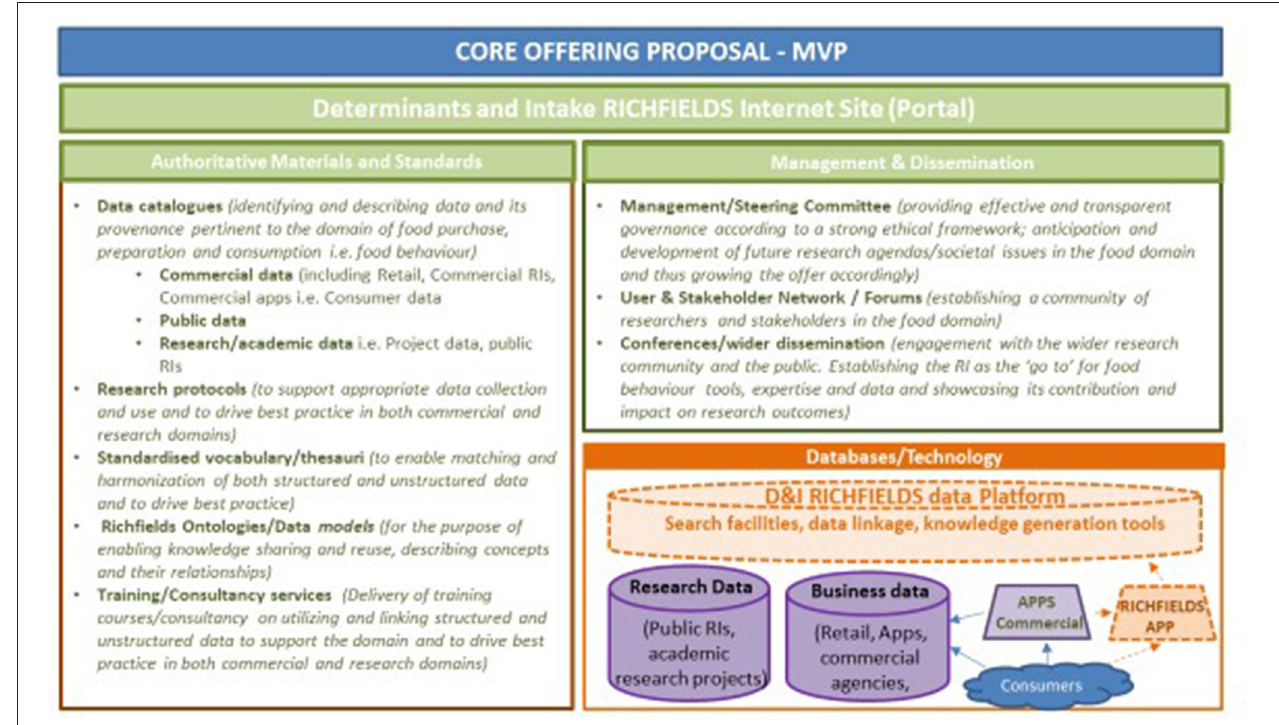
FIGURE 1 | Core offering of DI “Richfields” Data Platform - a minimum viable